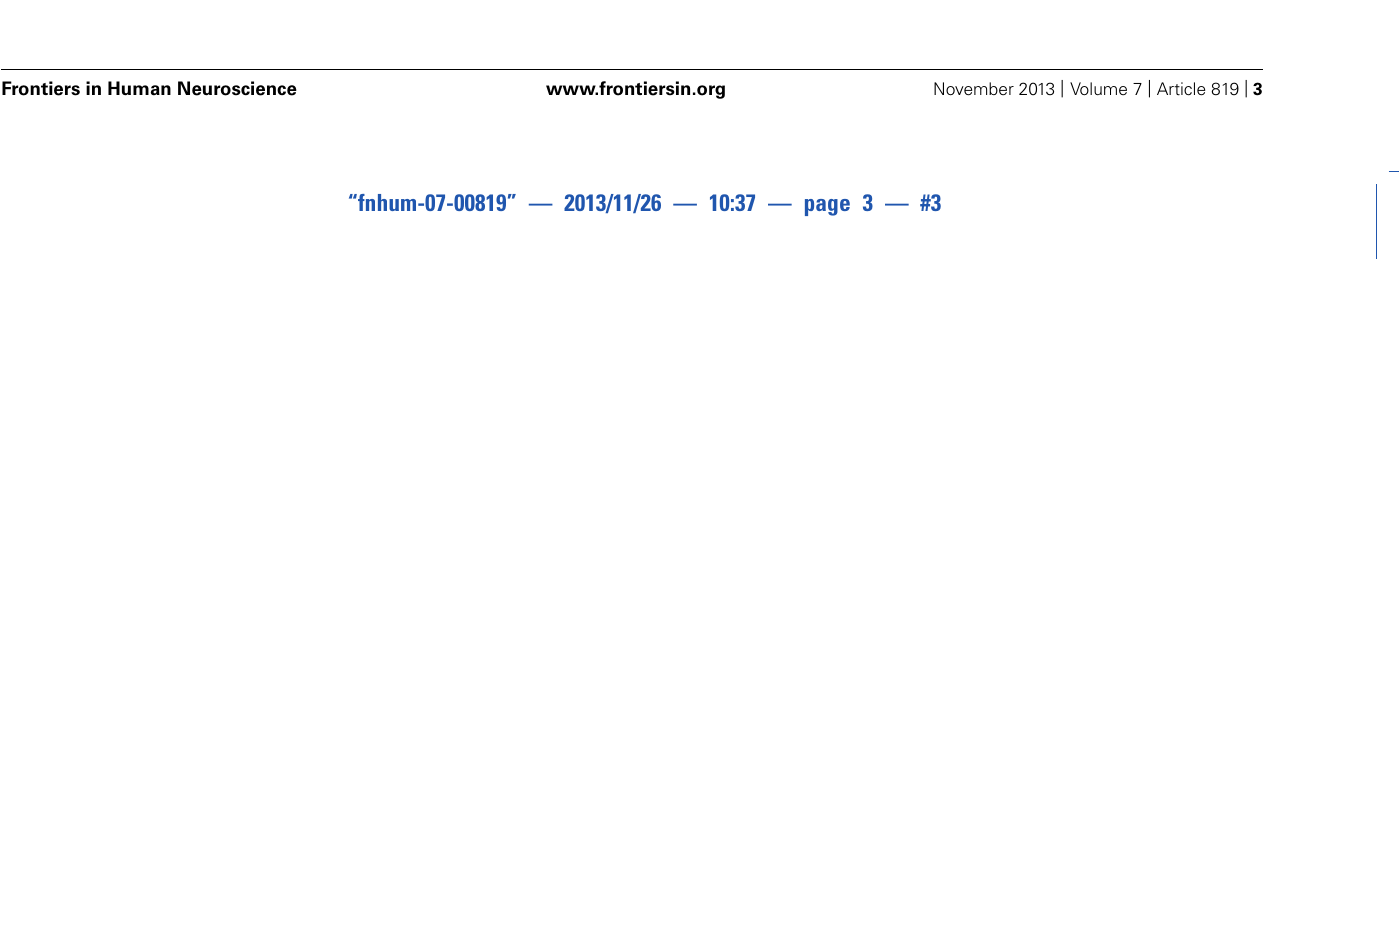
FIGURE 1 | Experimental setup. The video clips lasted for about 2 s depending on which occlusion (easy, medium, difficult) that was observed.There was no time limit for the response.The participants viewed a total of 120 video clips.